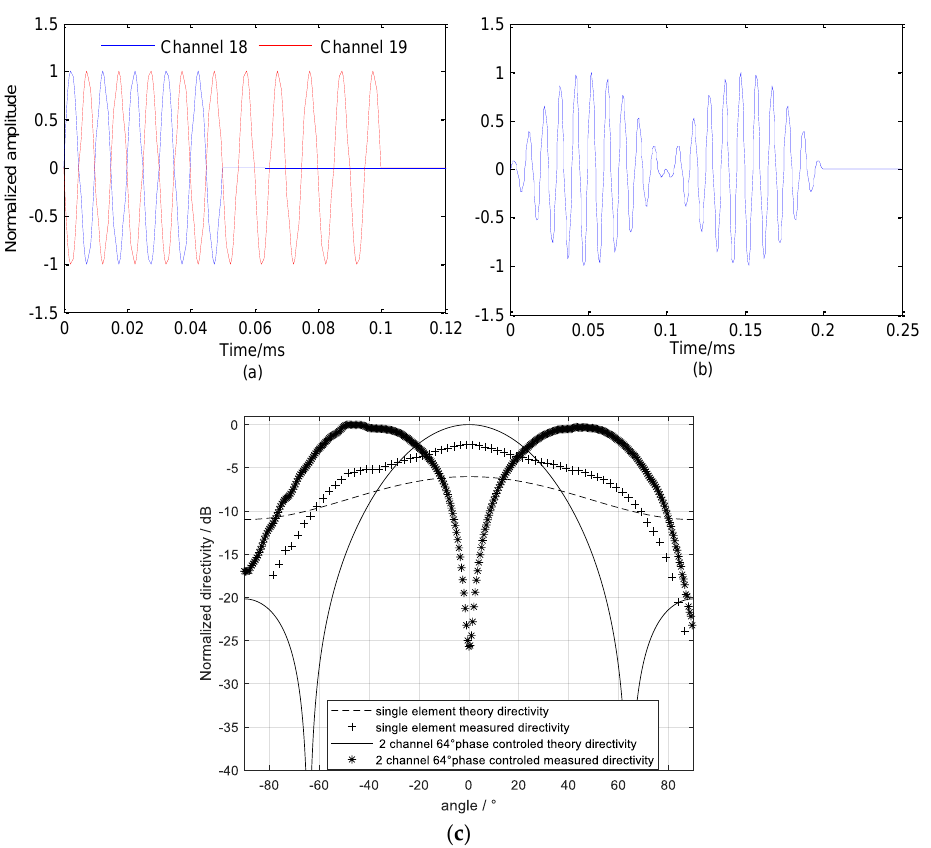
Figure 6. Time-domain spliced wide covered multibeam detection directivity and primary frequency signal. ( a ) Multibeam sound source signal; ( b ) sub-bottom profile sound source signal; ( c ) multibeam detection directivity.